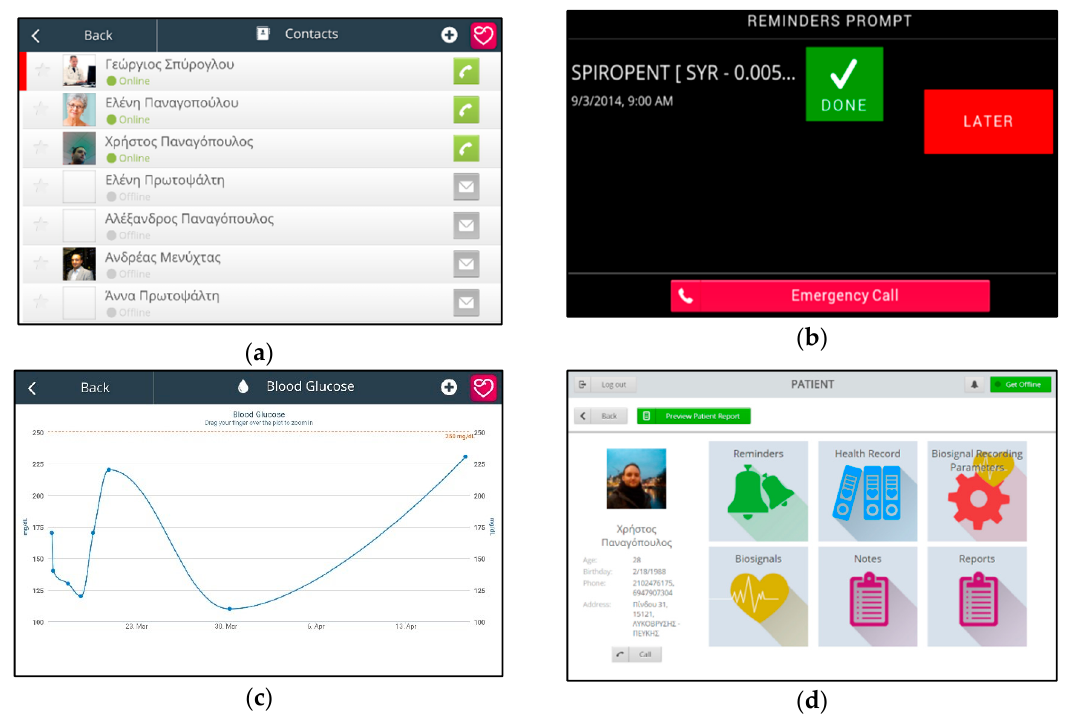
Figure 3. Application views: ( a ) Contact list; ( b ) reminder notification; ( c ) blood glucose levels history and ( d ) doctor’s patient management dashboard.